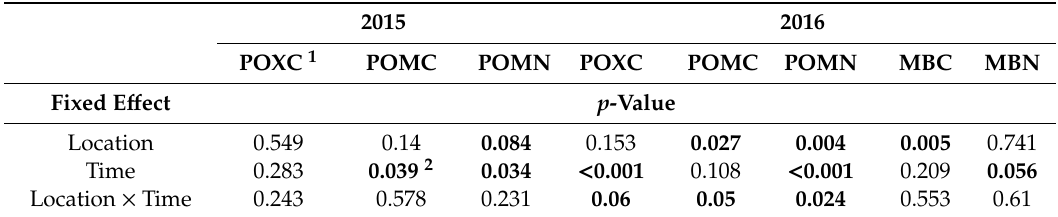
Table 1. Analysis of variance for soil quality indicators by soil location, sampling time, and their interaction within experimental